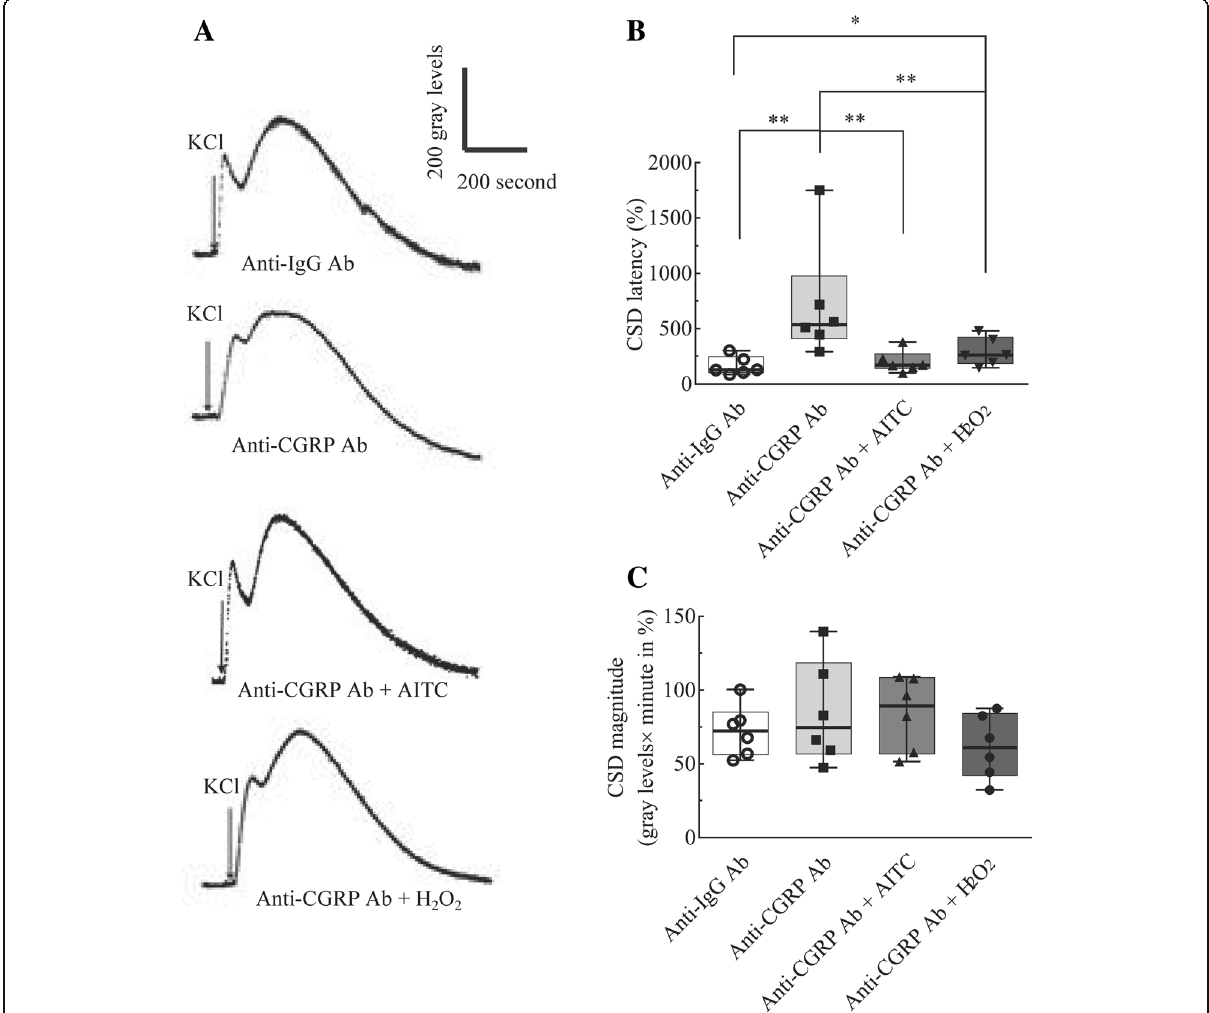
Fig. 6 Both ROS and the TRPA1 activation reversed the inhibitory effects of the anti-CGRP antibody on CSD in the mouse brain slice. CSD was induced by 260 mM KCl. There were four groups: anti-IgG antibody at 0.025 μ M (i, n = 6) as the control, anti-CGRP antibody at 0.4 μ M in the absence (ii, n = 6) or presence of 50 μ M of the TRPA1 agonist, AITC (iii, n = 6) or the ROS activator, H 2 O 2 (vi, n =6). In order to minimize the animal use, data in anti-IgG antibody control group and the anti-CGRP antibody were adopted and transformed from that in Fig. 5 in our recent paper [5]. Representative trace of the 2nd CSD episode in each group are shown in the panel a . The data showed that both ROS and the TRPA1 activation reversed the prolonged CSD latency ( b ), but not magnitude ( c ) under the perfusion of the anti-CGRP antibody. Data were plotted as percentage of their initial levels (1st CSD episode) and indicated as median (range). Mann-Whitney U test, one-tailed, was used for significant analysis between two independent groups. * p < 0.05, ** p < 0.01. Abbreviation: Ab indicates